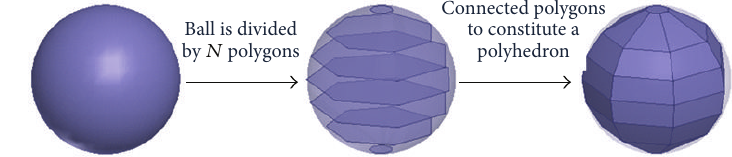
Figure 5: Change spheres into polyhedrons.